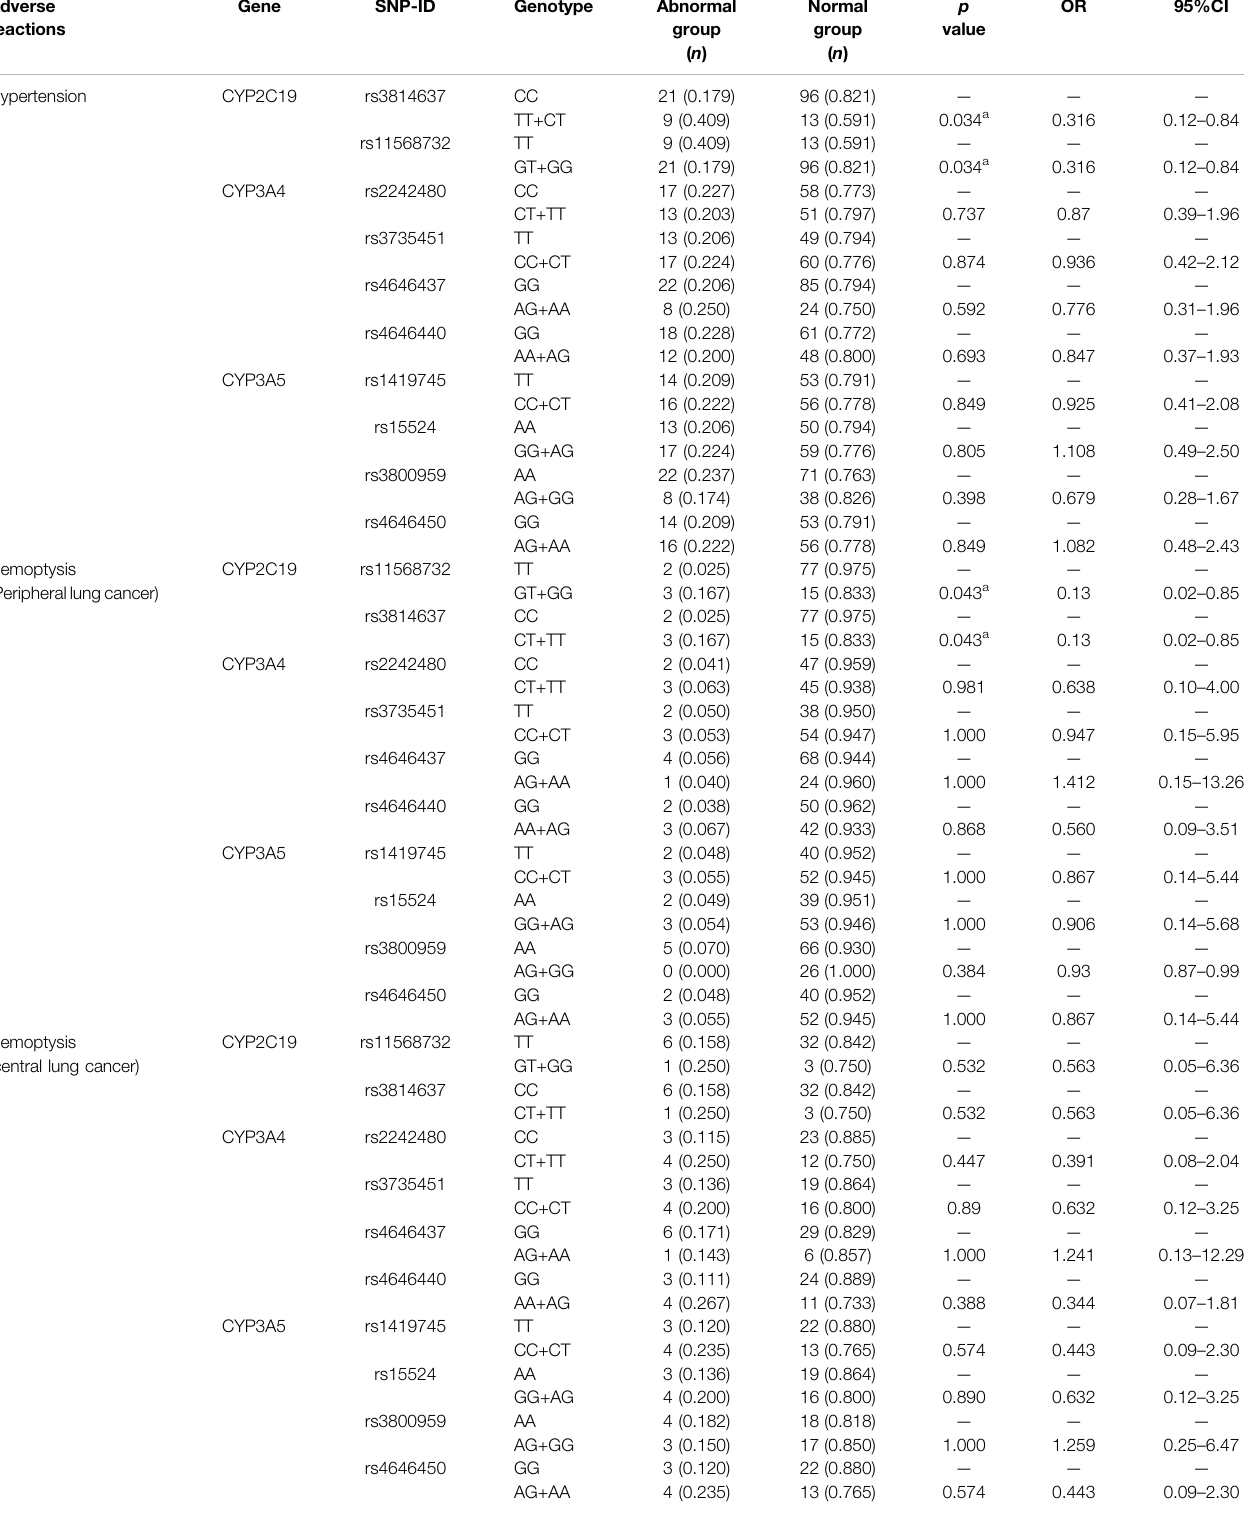
TABLE 4 | Correlation between genetic polymorphisms and adverse reactions. Adverse